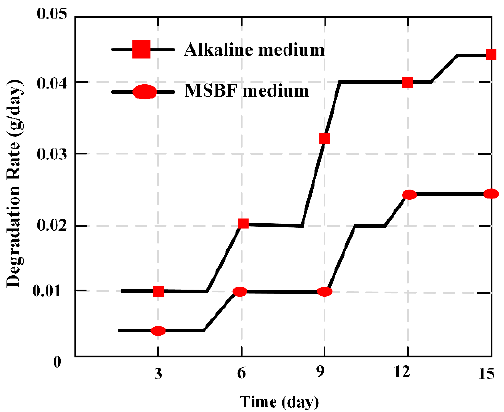
Figure 9. Degradation ratio (g/day) of MBAB with adding degradation time in alkaline medium and modified simulated body fluid (MSBF)medium over 15 days.